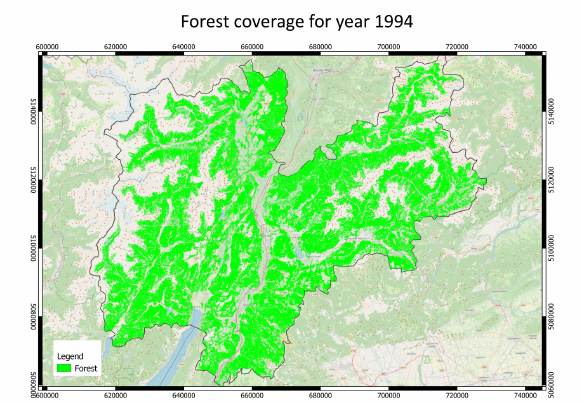
Figure 11. Forest coverage in the Trentino region in